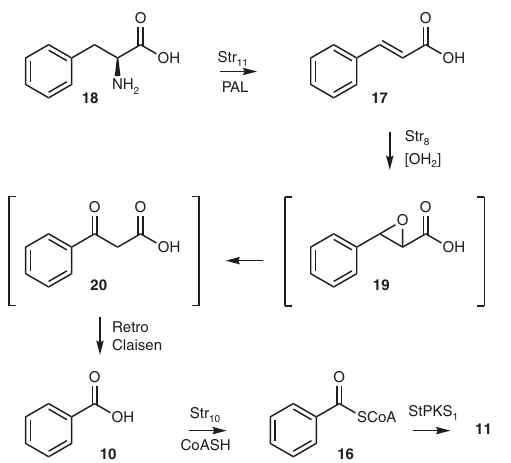
Fig. 5 Deduced biosynthetic pathway to benzoyl CoA in S. tenacellus . The pathway converts phenylalanine 18 to benzoyl CoA 16 , which is then the substrate for StPKS1 to give prestrobilurin A 11